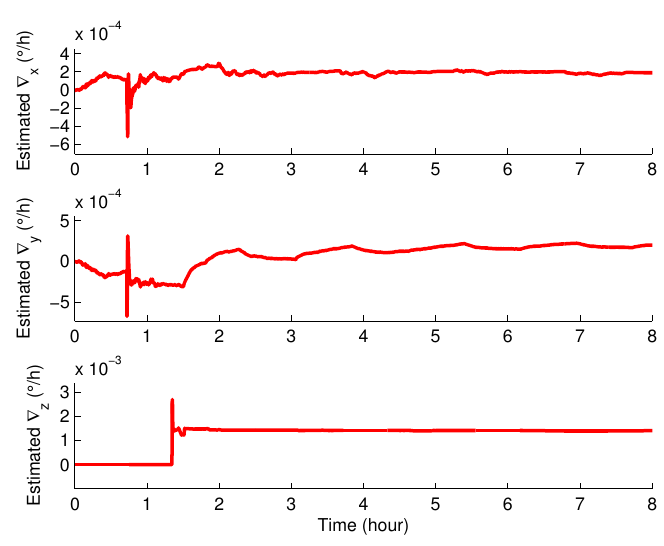
Figure 13. The estimated accelerometer biases.